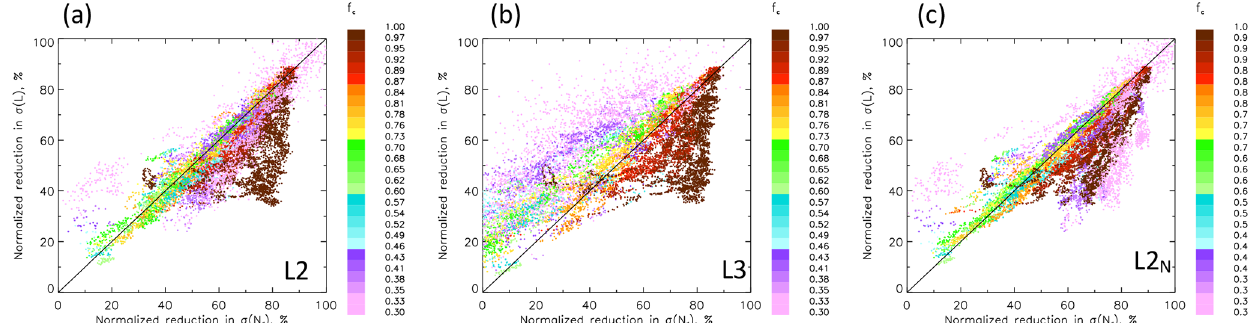
Figure B1. Effects of aggregation on normalized reduction in σ ( L ) vs. normalized reduction in σ ( N d ) to shed light on results in Fig. 10. Points are colored by f c . In (b) , and at low f c , aggregation tends to less significantly reduce σ ( L ) relative to σ ( A c ) (Fig. 7b). (a) L2, (b) L3, and (c) L2 N . See Appendix B for further discussion.